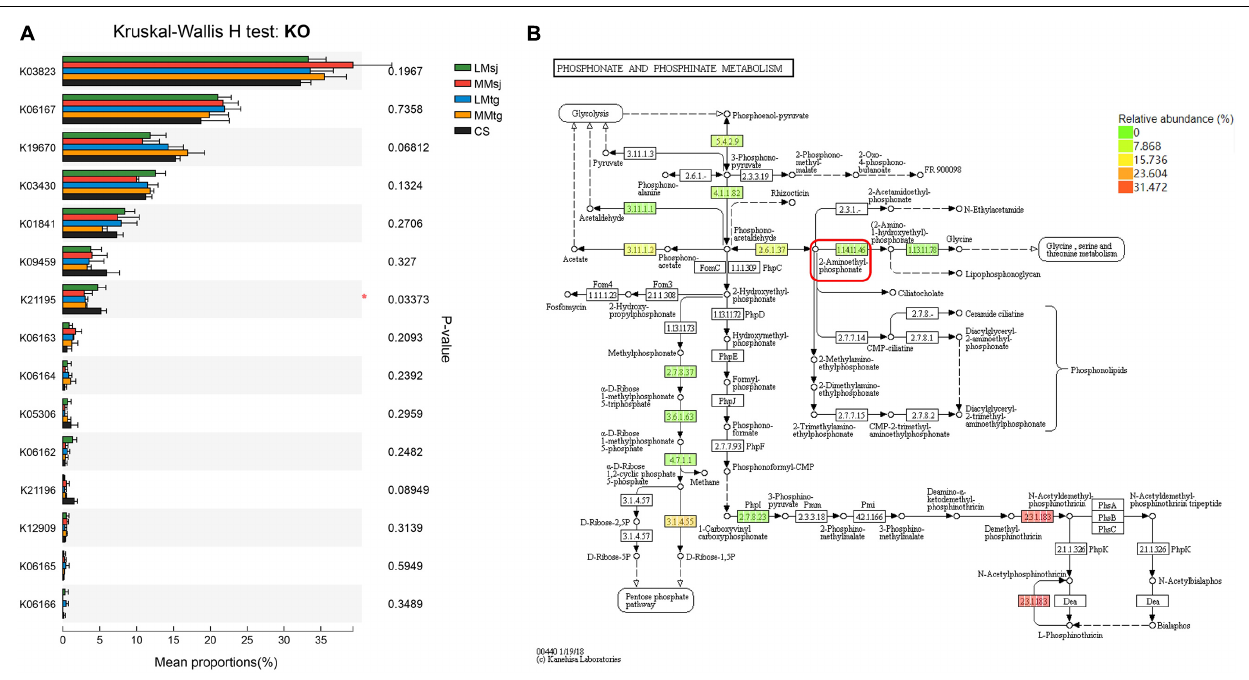
FIGURE 5 | (A) The Kruskal-Wallis H test bar plot of Kyoto Encyclopedia of Genes and Genomes Orthology (KO) relating to phosphorus metabolism in topsoil; (B) The diagram of phosphorus metabolism pathway in topsoil. * P < 0.05. TABLE 2 | Concentration of available phosphorus (AP) and total phosphorus (TP) in topsoil (0–40 cm). Parameter